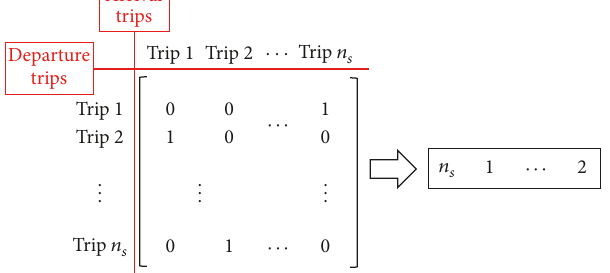
Figure 8: The solution representation of a single station.